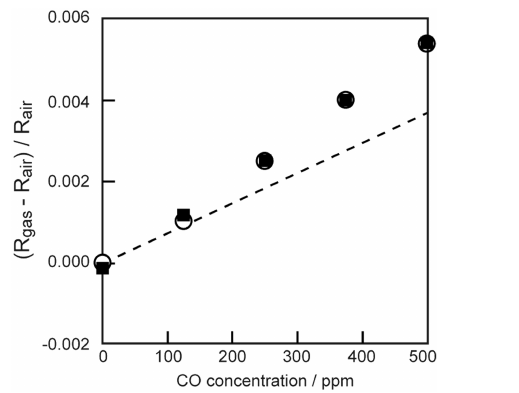
Figure 3. Signals at various CO concentrations ( (cid:13) : increasing, (cid:4) : decreasing) from a catalytic combustion-type sensor incorporating AlN at 70 ◦ C. Dashed line indicates the sensor signal obtained pre- viously with a sensor without AlN (Hosoya et al.,